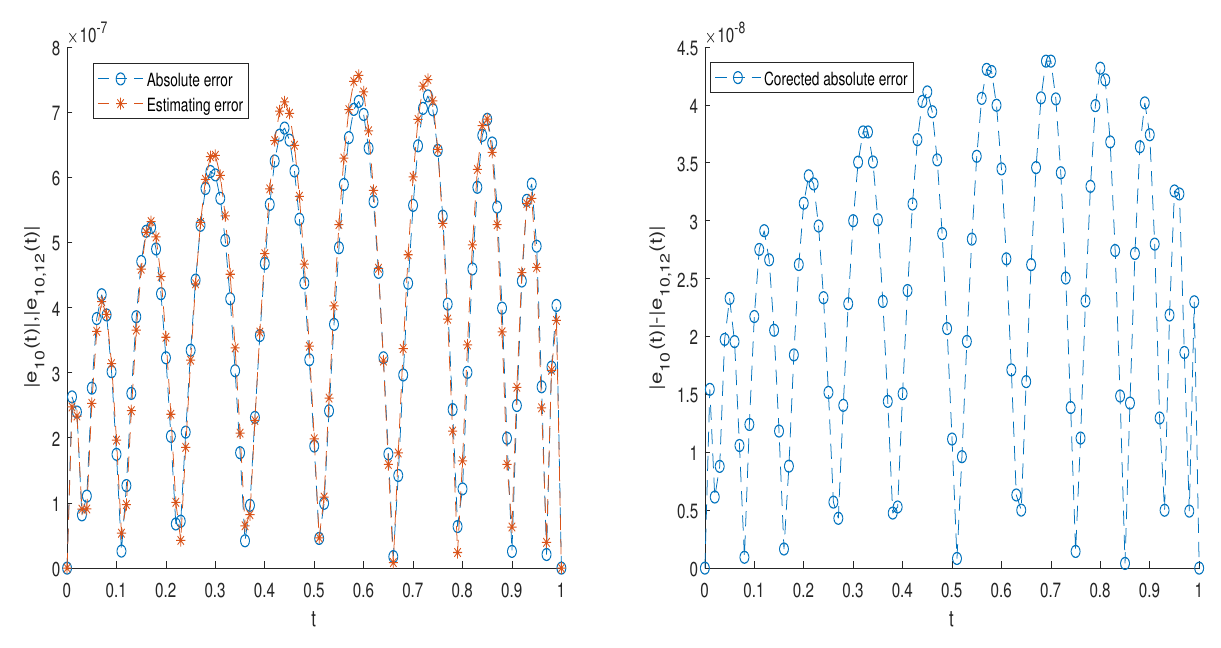
Figure 10. The absolute error, estimation of absolute error and the corrected absolute error for Example 4 for ( N , M ) = ( 10,12 )